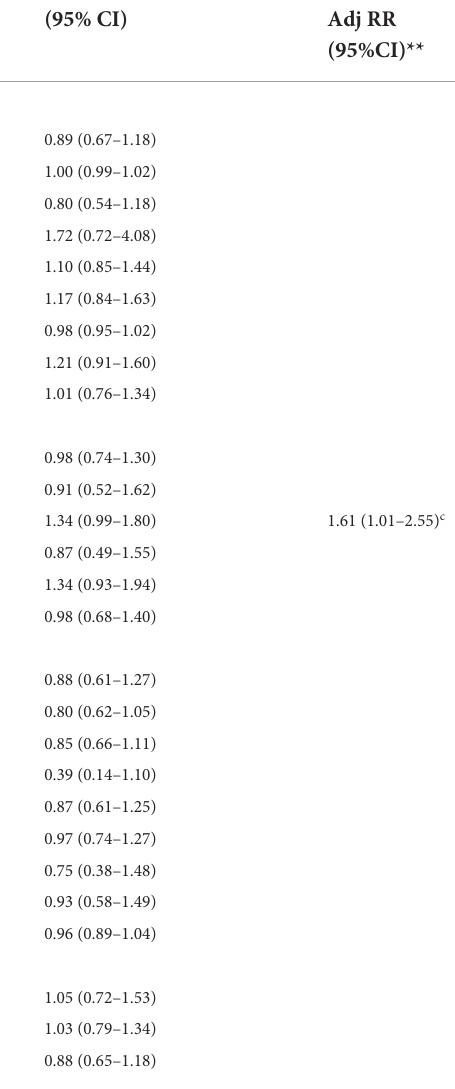
TABLE 2 Factors Associated with COVID-19 Vaccination among PWID in Tijuana, Mexico. Baseline